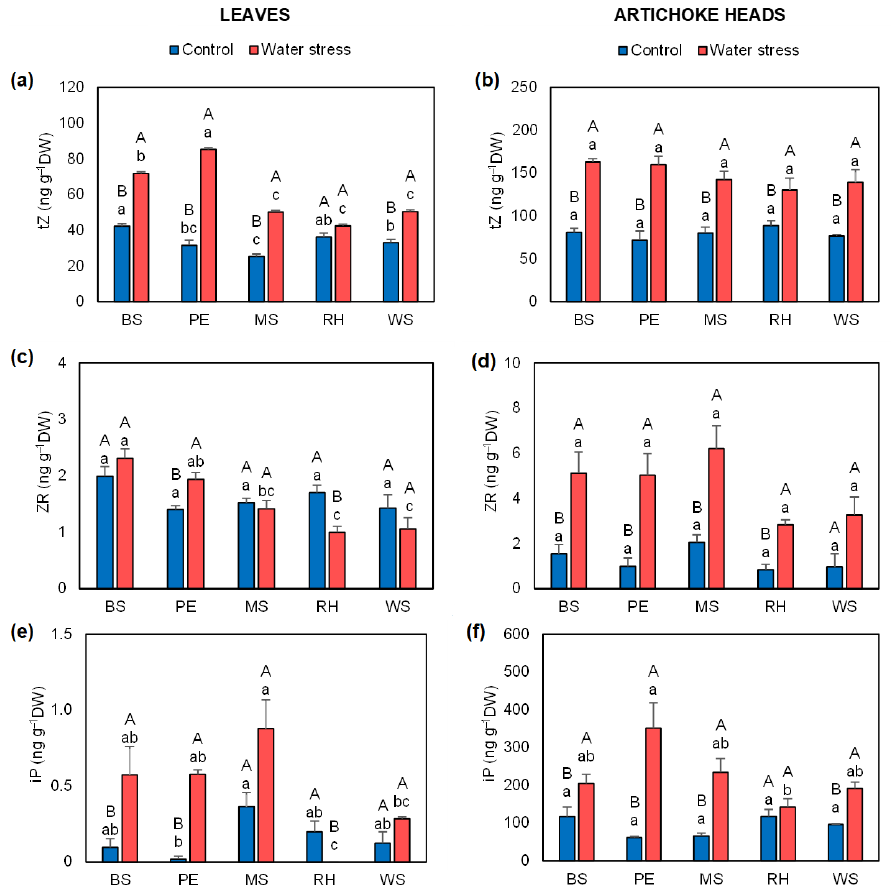
Figure 4. ( a , b ) Trans-zeatin (tZ), ( c , d ) zeatin riboside (ZR), and ( e , f ) isopentenyladenine (iP) in leaves and heads of artichoke plants of the commercial Symphony variety non-mulched or subjected to different mulching treatments and cultivated under control (well-watered) and water-stress (70% ETc) conditions. Bars show the means of five plants ± standard error. Different capital letters indicate significant differences due to the water-stress treatment, while different small letters show significant differences among mulching treatments according to Tukey’s test ( p ≤ 0.05). Abbreviations used: bare soil (BS), polyethylene mulch (PE), mushroom-substrate-based hydromulch (MS), rice-hull-based hydromulch (RH), and wheat-straw-based hydromulch (WS).